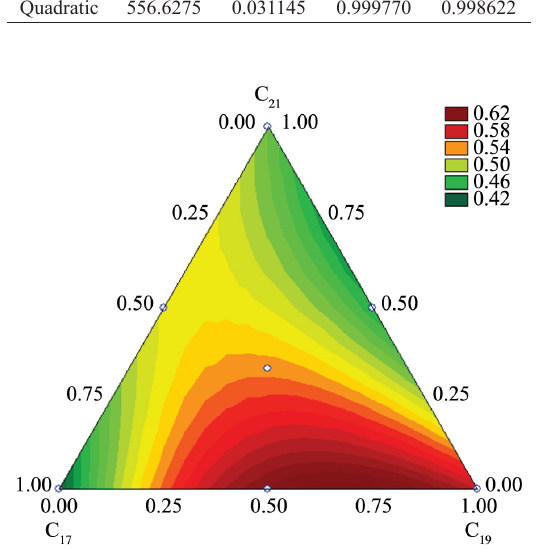
Figure 9. Response models for CO C C C C andC 17 21, 19 21